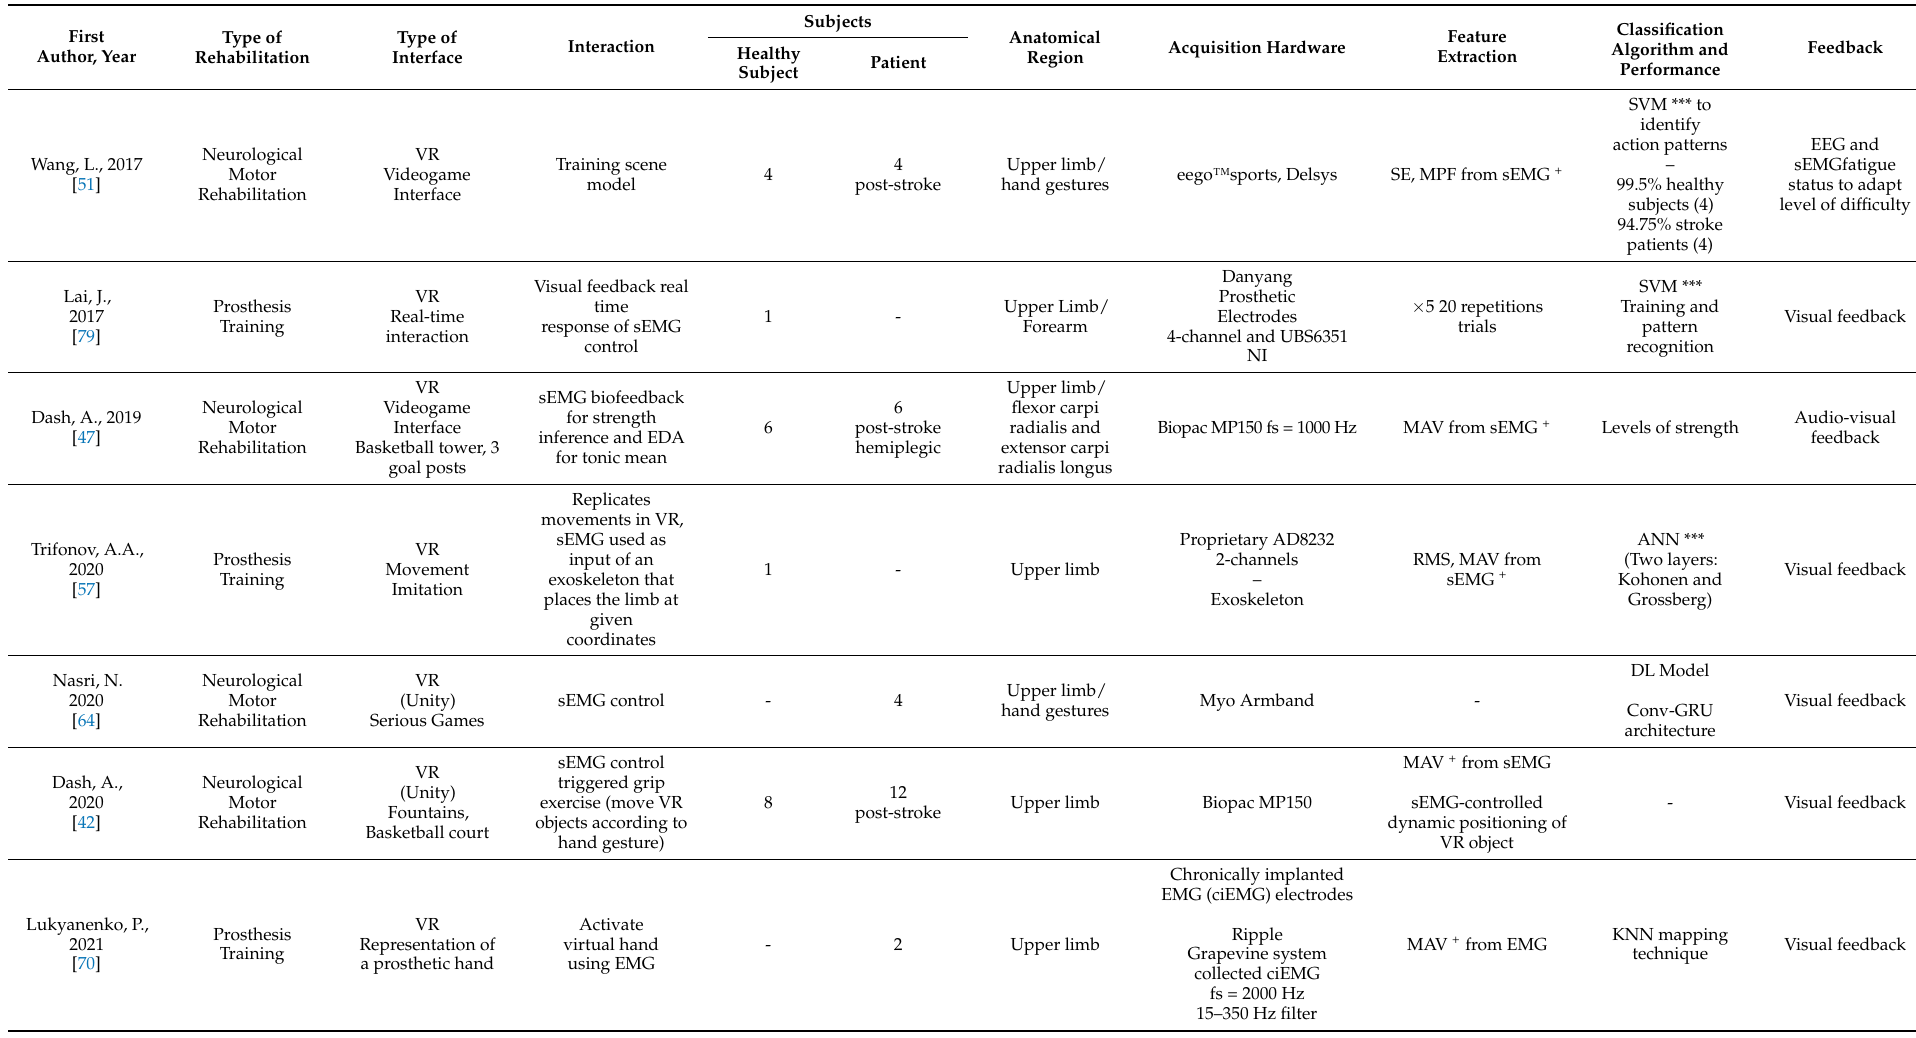
Table 2. CI interfaces used for motor rehabilitation based on sEMG